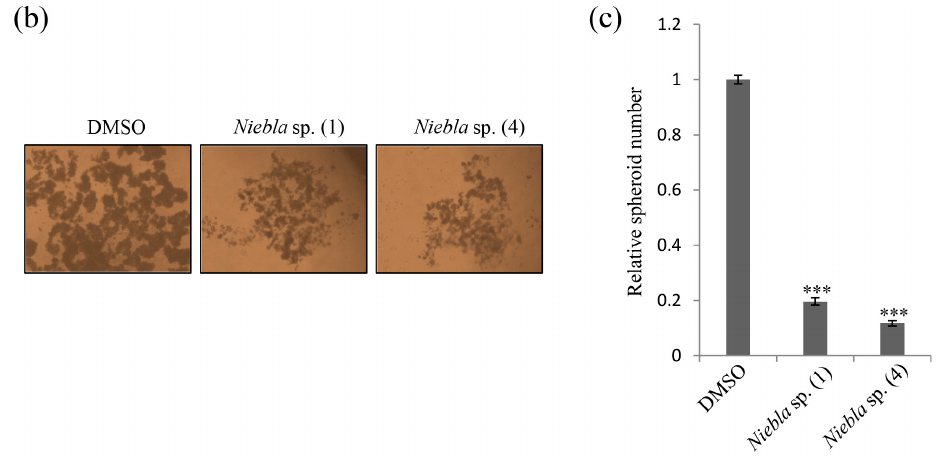
Figure 1. Acetone extracts of lichens collected in Chile decrease CSC221 cell stemness. ( a ) Quantitative analysis of Gli-luc reporter assays of NIH 3T3 cells (stably incorporating Gli-dependent firefly luciferase and constitutive Renilla luciferase reporters) treated with 5 µg/mL acetone extracts of Ramalina sp. (1), Everniopsis trulla , Neocatapyrenium sp., Niebla sp. (1), Roccella sp., Niebla sp. (2), Niebla sp. (3), Neocatapyrenium sp., Everniopsis trulla , Niebla sp. (4), and Ramalina sp. (2) for 48 h. ( b ) Representative images of spheroid formation of CSC221 cells treated with extracts of Niebla sp. (1) or Niebla sp. (4) for 14 days. ( c ) Quantitative analysis of the number of spheroids following each treatment. Quantitative data were obtained from three independent experiments ( n = 3). Data represent mean ± standard error of the mean (SEM), and analysis was performed by one-way ANOVA. *** p < 0.001 compared with dimethyl sulfoxide (DMSO)-treated CSC221 cells.